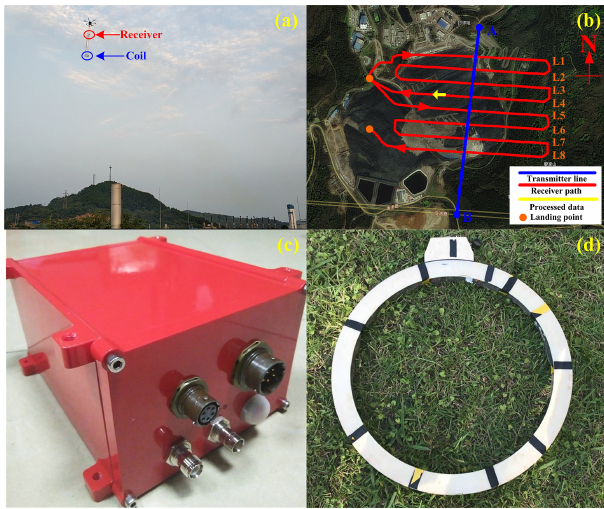
Figure 5. The survey area and flight paths on the refuse landfill of Longquanyi District, Chengdu, in China. (a) The receiver system is mounted on UAV along with the paths; (b) the blue line was the transmitter source and the red curves were the survey paths of the receivers, the lines of L1 through L8 represent different paths and the orange dots represent the landing point for UAV; (c) the receiver instruments; (d) the receiving coil with a diameter of 50cm. The flight heading was from east to west on the L4 path. The data of part of L4 (yellow arrow solid line) will be processed and the du- ration was 60s. The satellite image embedded in (b) came from https://map.tianditu.gov.cn/ (last access: August 2018) built by the National Geomatics Center of